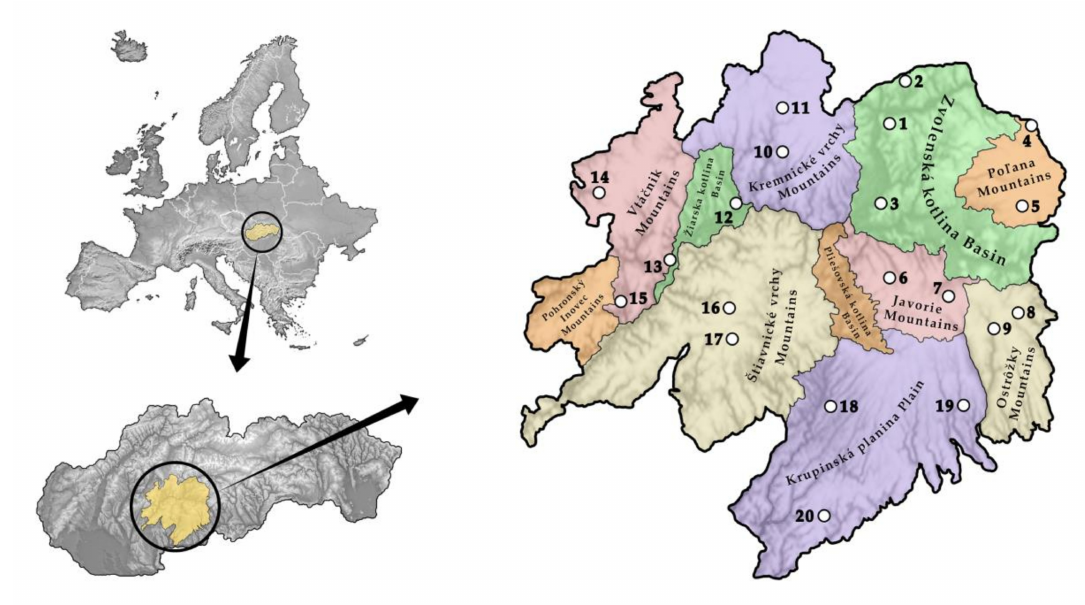
Figure 1. Map of the location of Slovakia in Europe and of the Slovensk é stredohorie Upland in Slovakia, their geographical units, and selected study